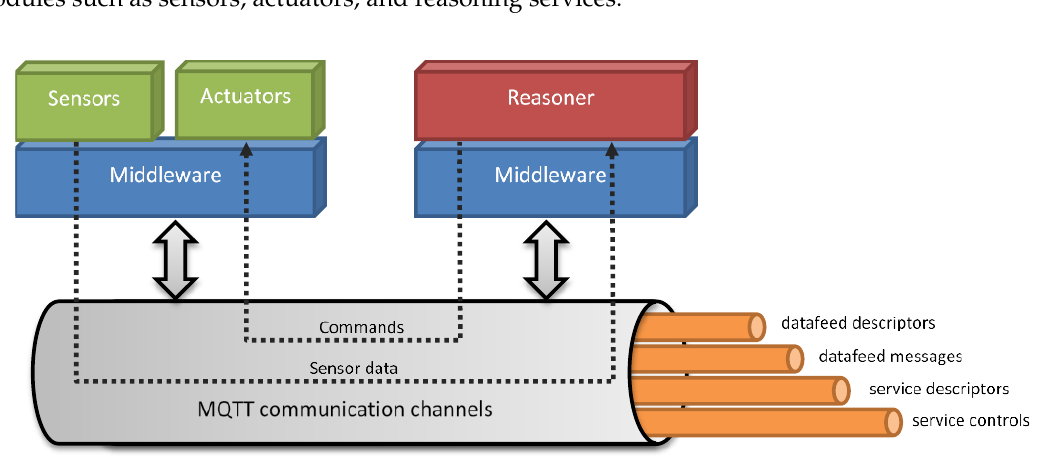
Figure 2. Overview of the communication platform.